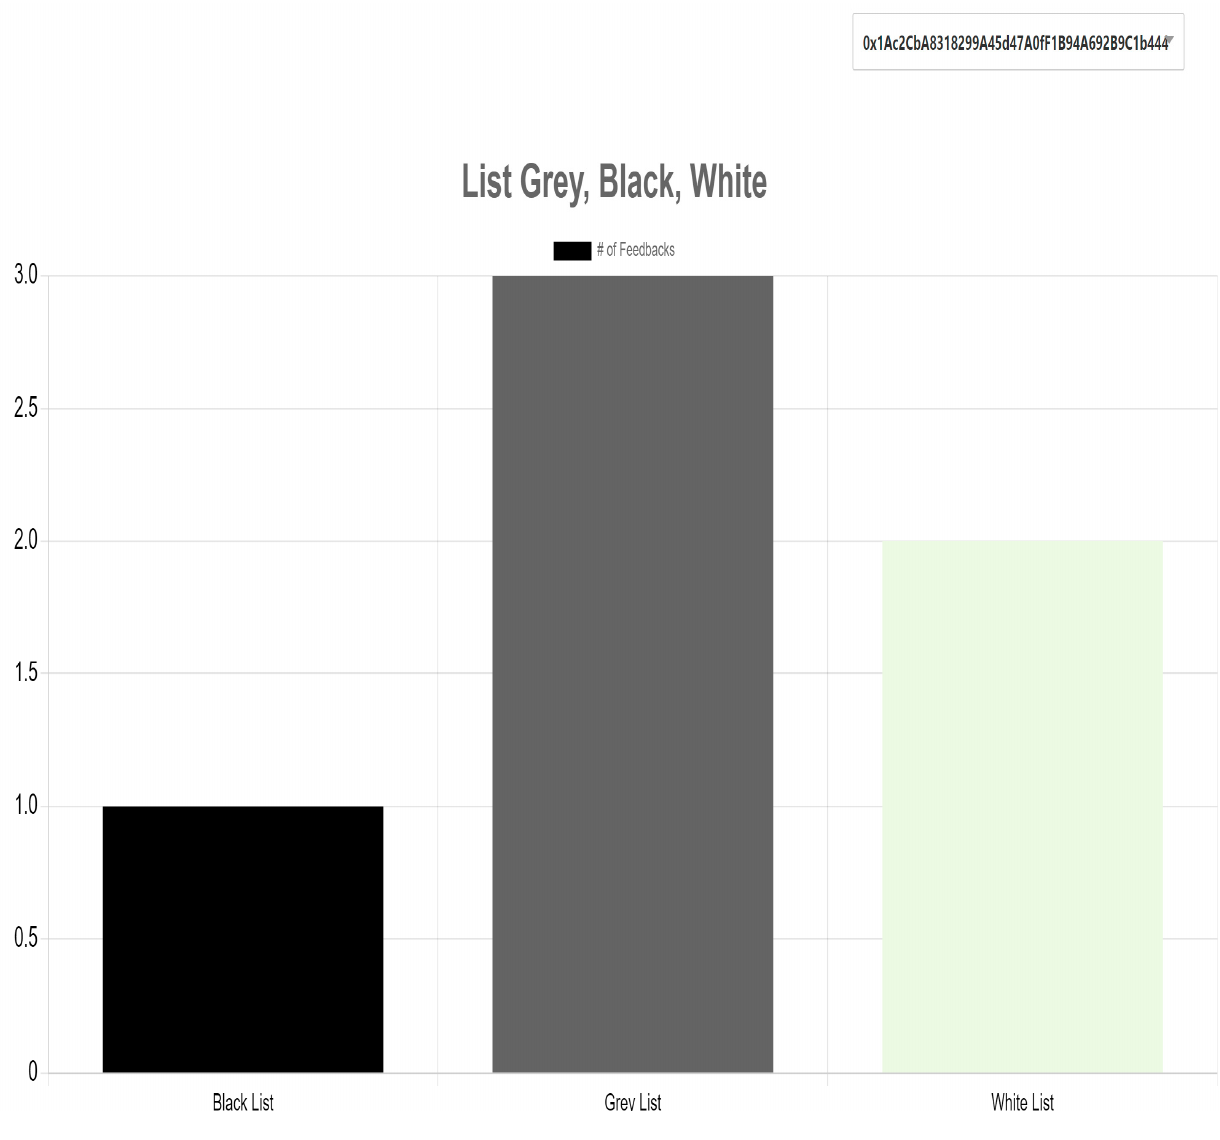
Figure 9. Variation in SP status based on the Reputation Values for SP2.